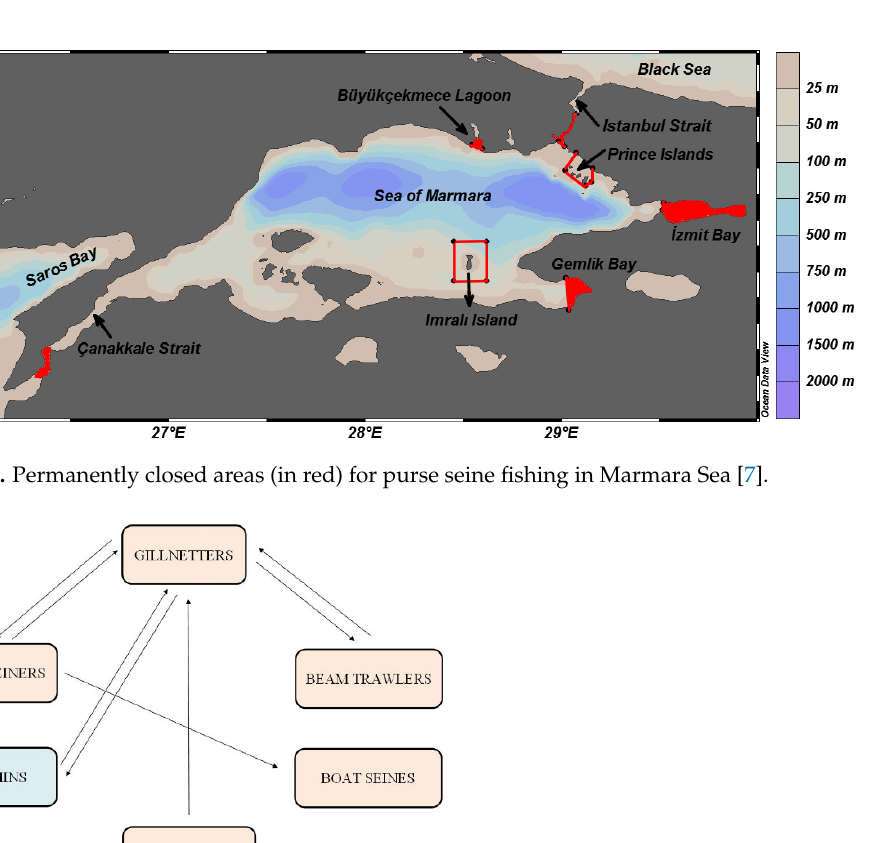
Figure 2. Conflicts between resource users in the Sea of Marmara [8,9]. The direction of the arrows displays the source of conflict.